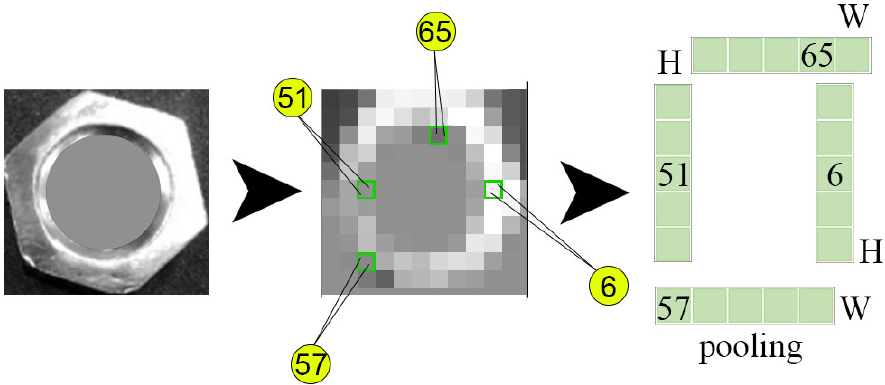
Figure 11. The detected k percentage values of the metal nut piece whose surface image is captured (belongs to the product without error).